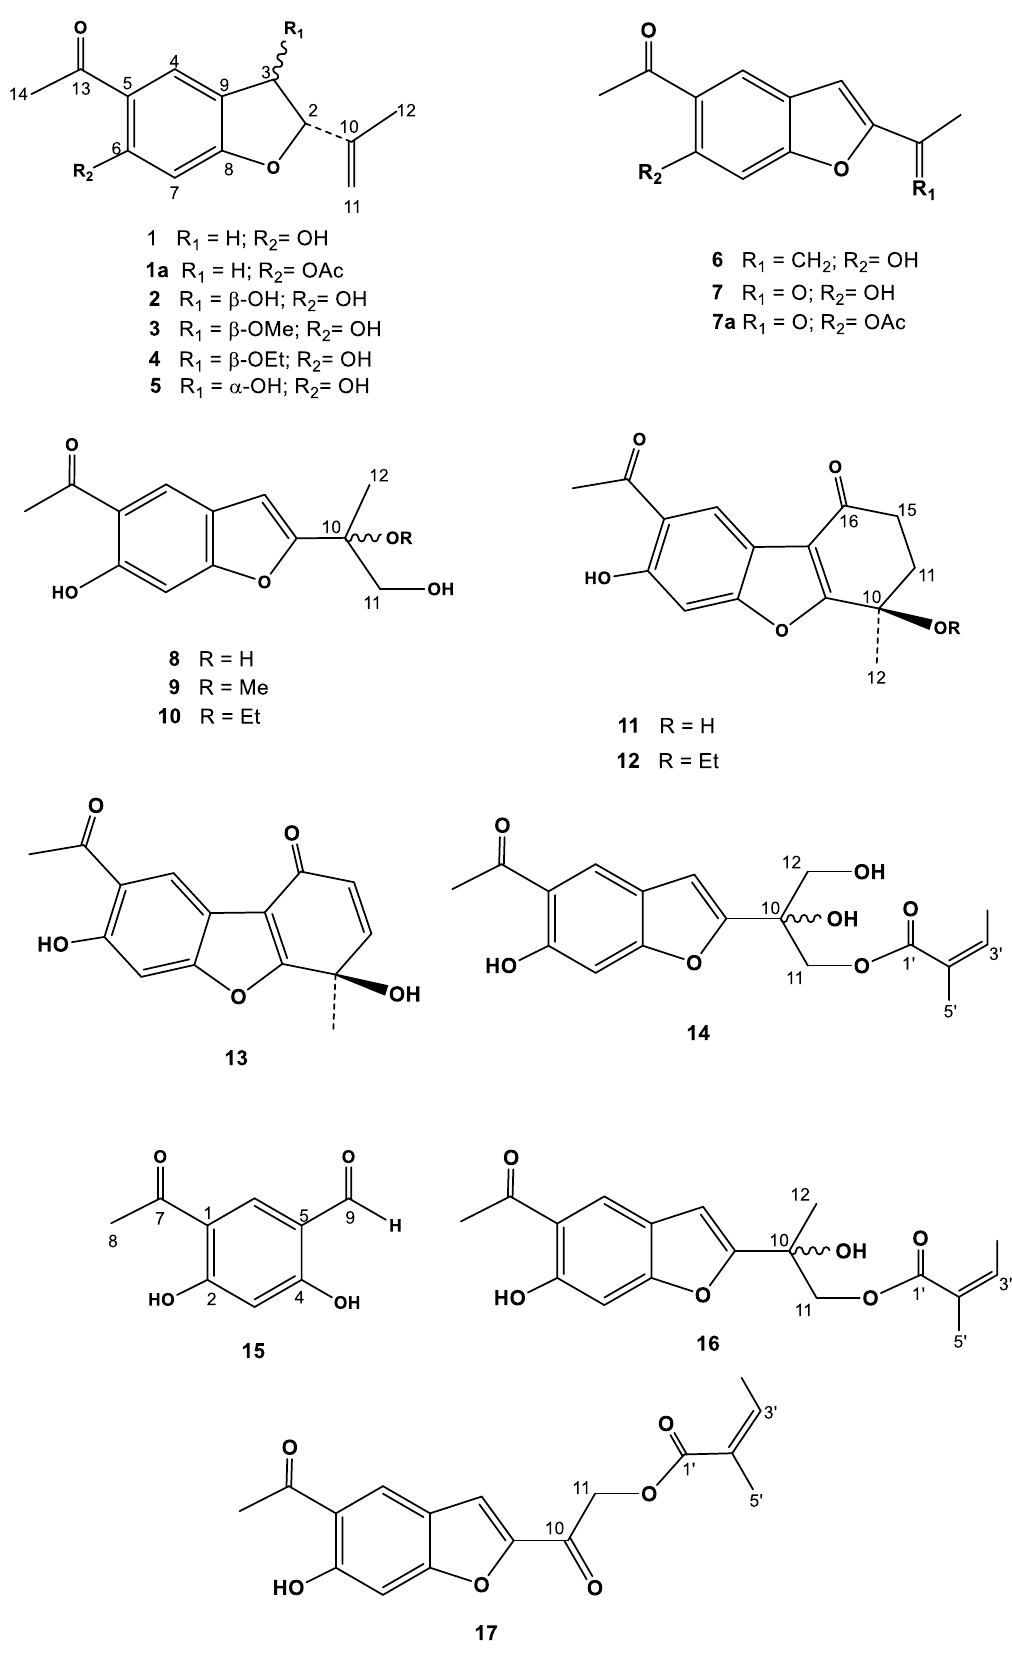
Figure 1. Chemical structures of compounds 1 – 17.